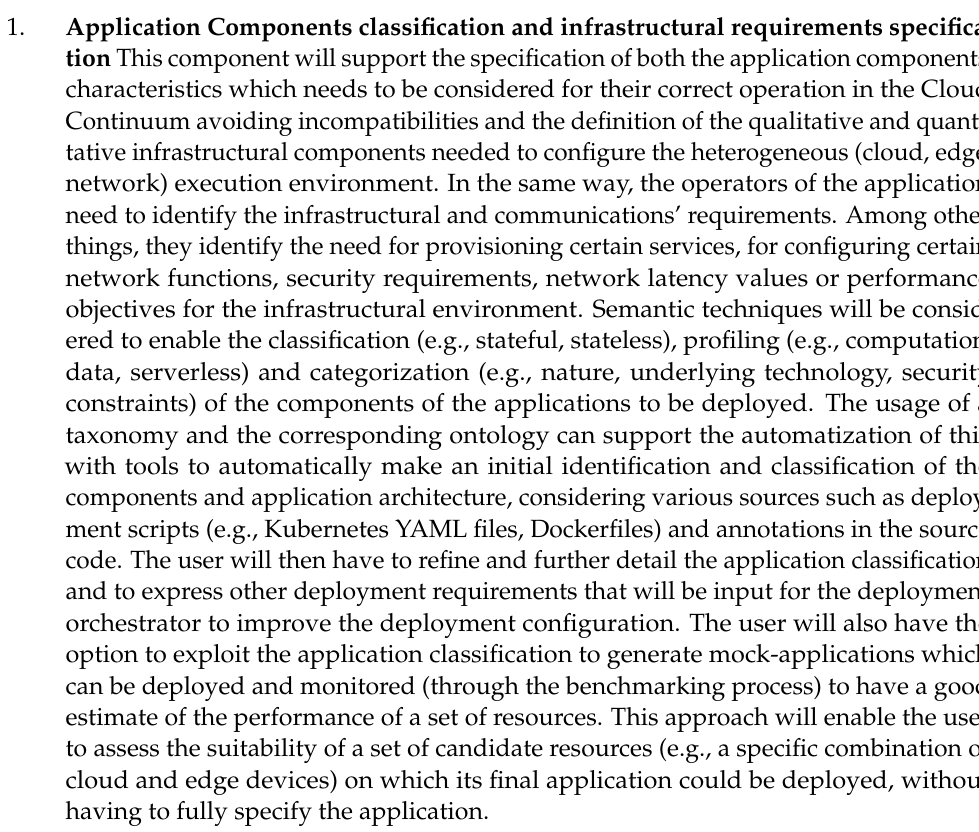
Figure 3. CloudOps reference framework for the Operationalization of applications in the Cloud Figure 3. Continuum.